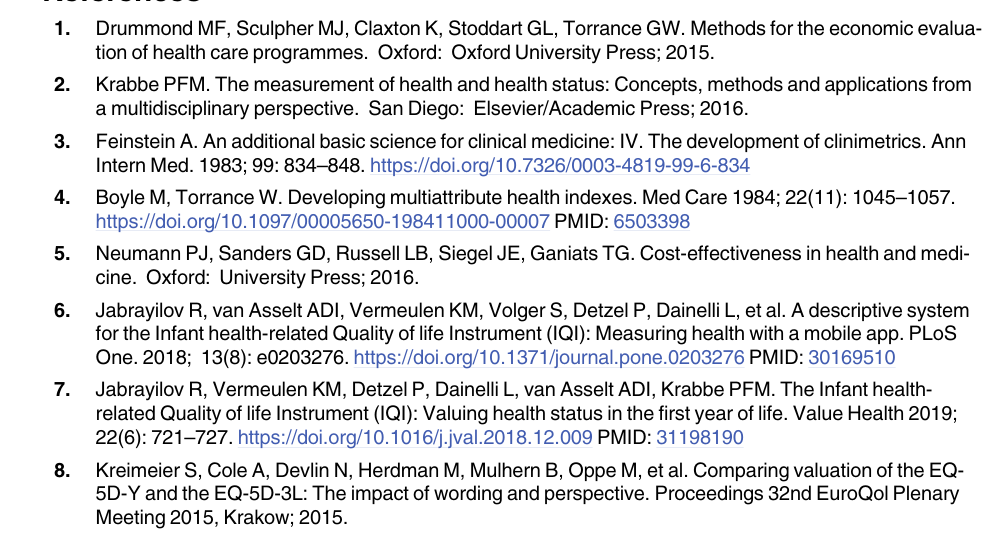
S3 Table. Parameter estimates (normalized scale = utilities) for the levels of the 7 IQI health items for the primary caregivers, per